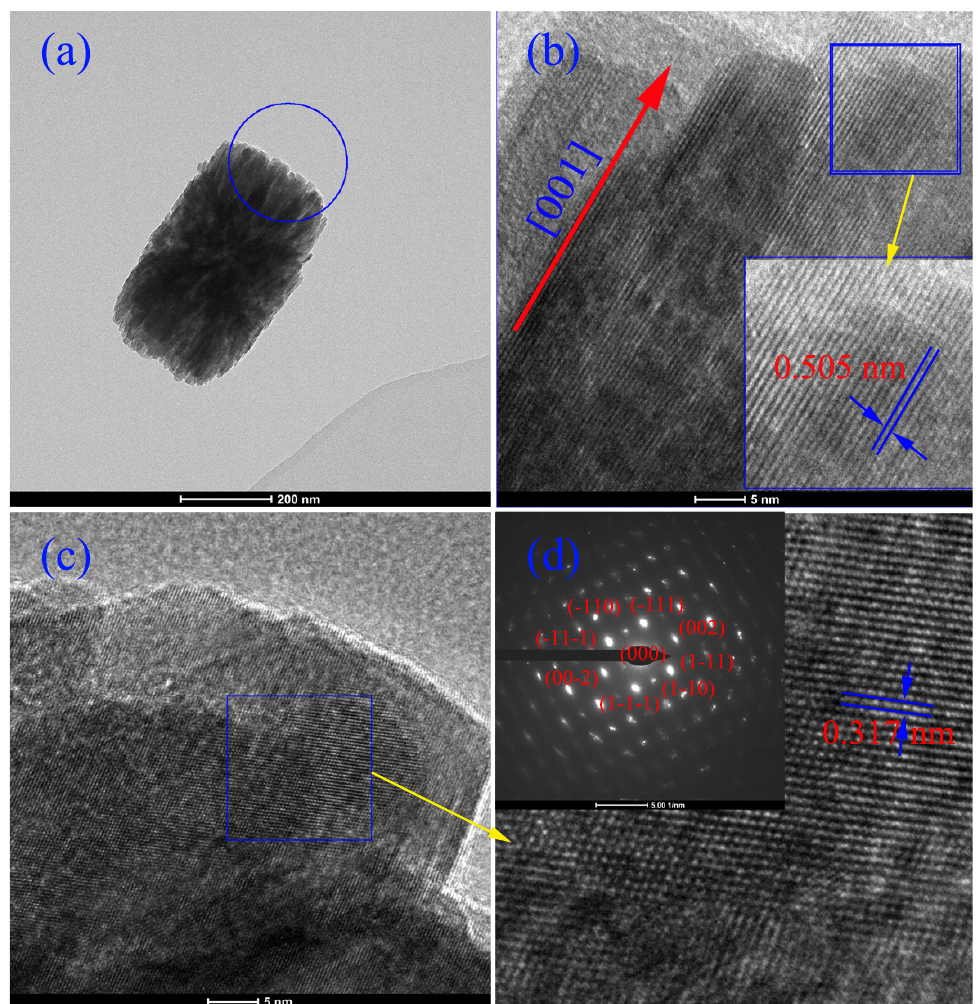
Figure 5. HRTEM and SEDA images of HT-ZrO 2 (0.01) particle with octahedron-like shape. ( a ) TEM image of a octahedron-like particle, ( b ) HRTEM image on [010] zone axis. ( c ) HRTRM image on [110] zone axis and its SAED pattern ( d